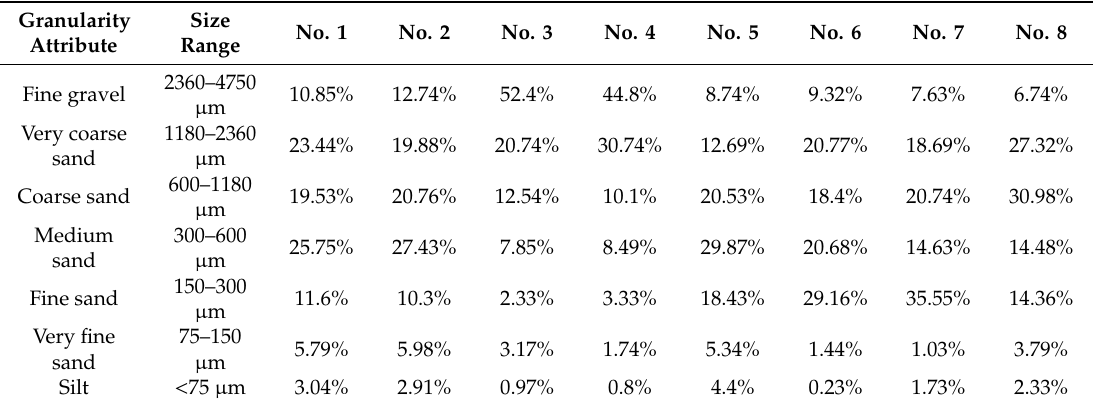
Table 9. Particle size distribution of clogging materials at di ff erent collection locations in the spring-thawing season.